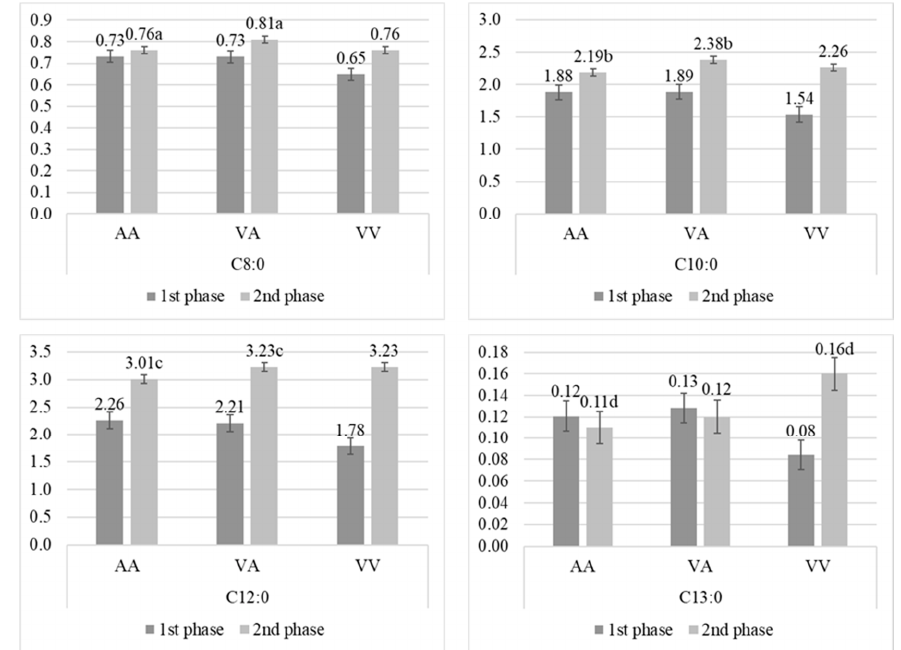
Figure 3. Percentage (mean ± SE) of C8:0, C10:0, C12:0, and C13:0 fatty acids in milk from Polish Holstein-Frisian cows during first and second phase of lactation depending on A293V single nucleotide polymorphism (SNP) in stearoyl-CoA desaturase ( SCD1 ) gene. a, b, c, d—values differ significantly between polymorphisms within fatty acid ( p < 0.05). Animals 2020 , 10 , x